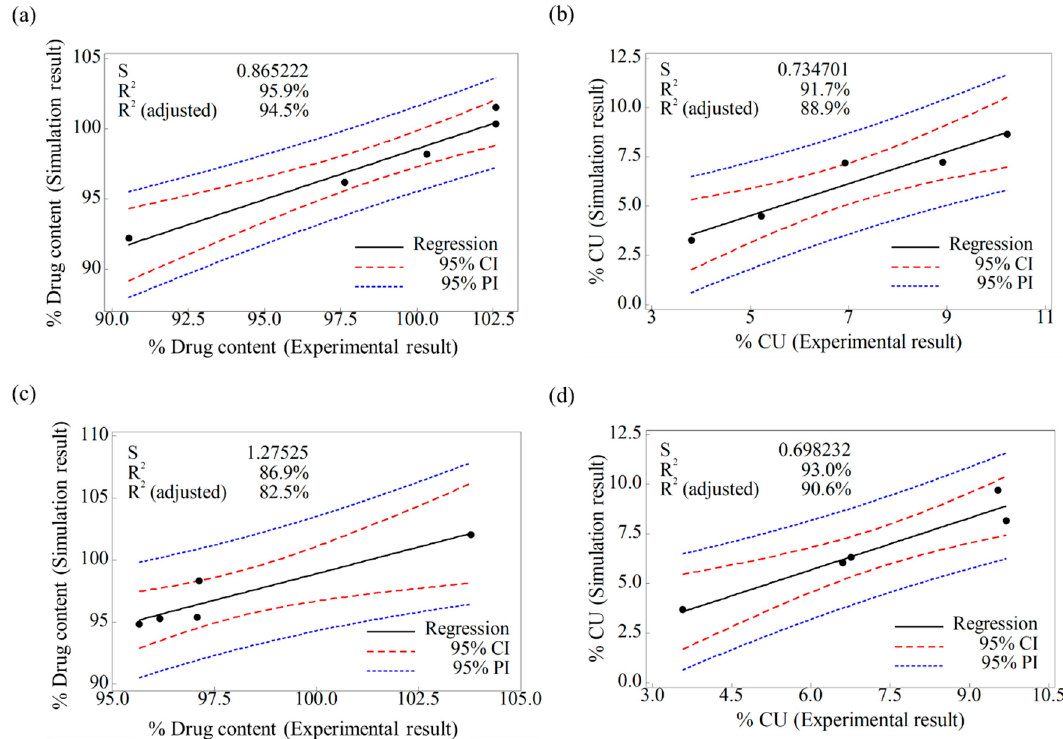
Figure 12. Fitted line plots of the experimental and simulation results at pilot-scale: ( a ) drug content (%) in V-blender, ( b ) CU (%) in V-blender, ( c ) drug content (%) in double-cone blender, and ( d ) CU (%) in double-cone blender. The black line, red dotted line, and blue dotted line denote the regression, 95% confidence interval (CI), and 95% prediction interval (PI), respectively.